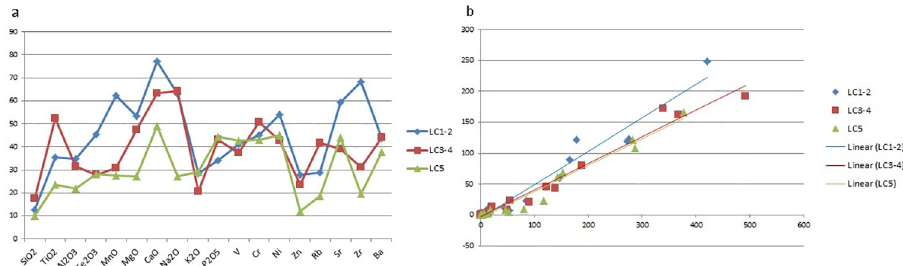
Fig 7. a. Mean of the CVs calculated for each element within each LC sub-phase; b. Relationships between mean (x- axis) and standard deviation (y-axis) for all chemical elements within each LC sub-phase.